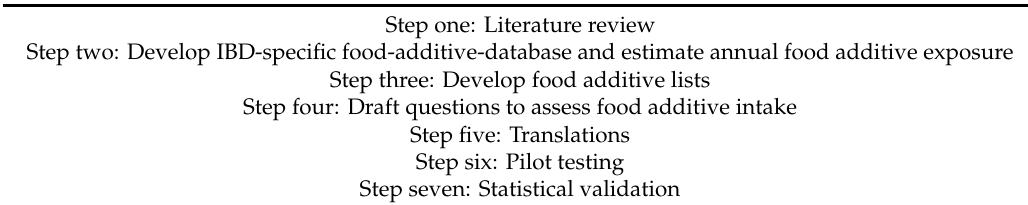
Table 1. Steps taken to design and evaluate food additive surveys.